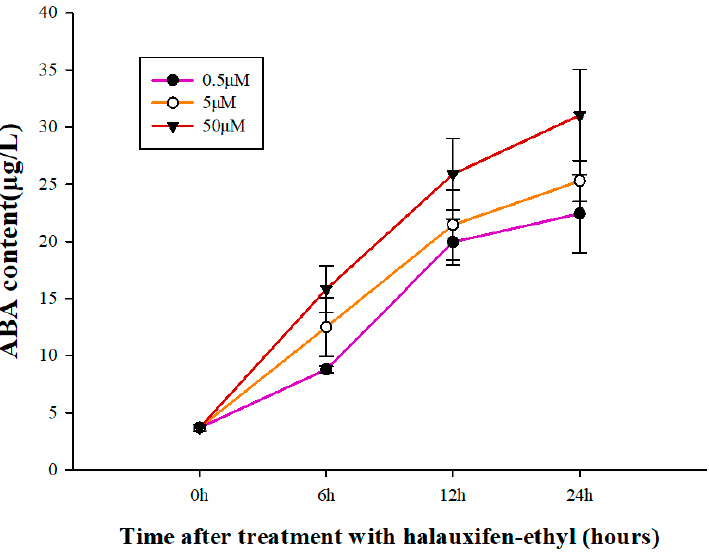
Figure 5. The effects of halauxifen-methyl on ABA levels in shoot tissue of treated Galium aparine . Vertical bars represent the standard errors of the means.